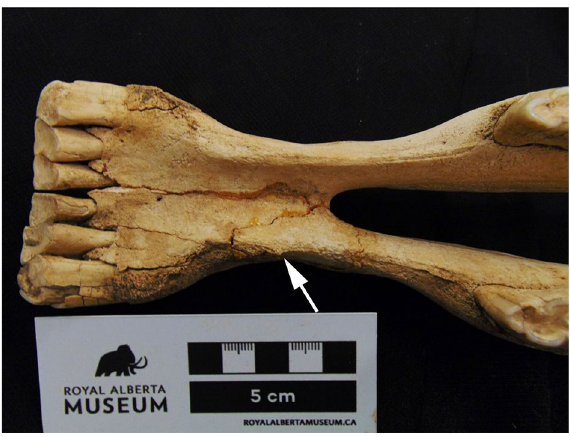
Figure 5. Mandibular bone formation on wild Pleistocene horse (specimen n o DhPg-8: 861.1; Royal Alberta Museum) from Wally’s Beach, Alberta, earning a score of “2” on the system devised by Bendrey 6